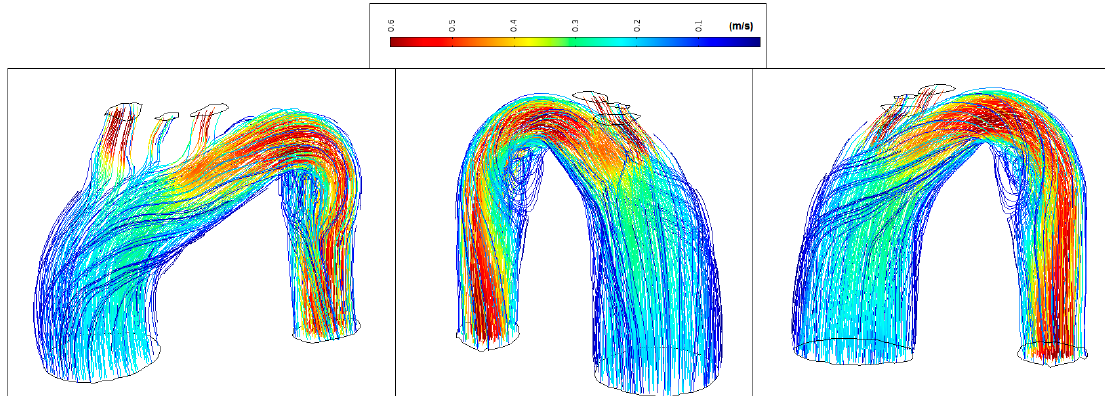
Figure 13. Patient 2: velocity streamlines (peak systole).